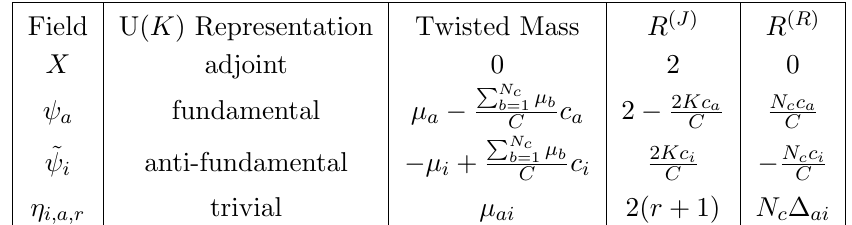
Table 2 . The spectrum on the worldsheet in cases where the string admits no ~ q